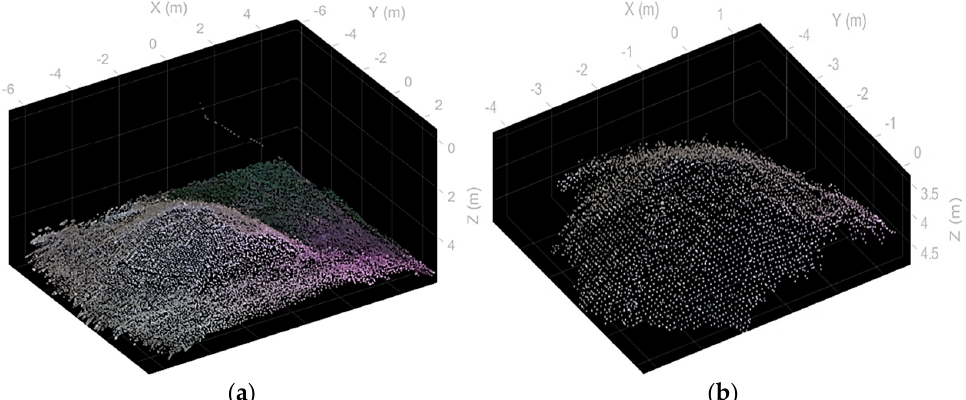
Figure 10. Construction site reconstruction obtained through the direct pose of depth frames. ( a ) Overall scene. ( b ) Segmentation of the stockpile. Table 3. Construction site experiment, quantitative data.